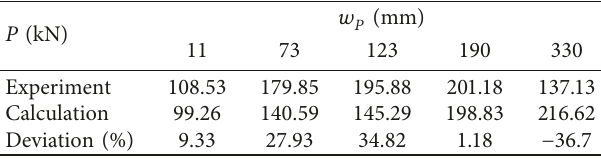
Table 2: Comparisons between calculations and experimental results.